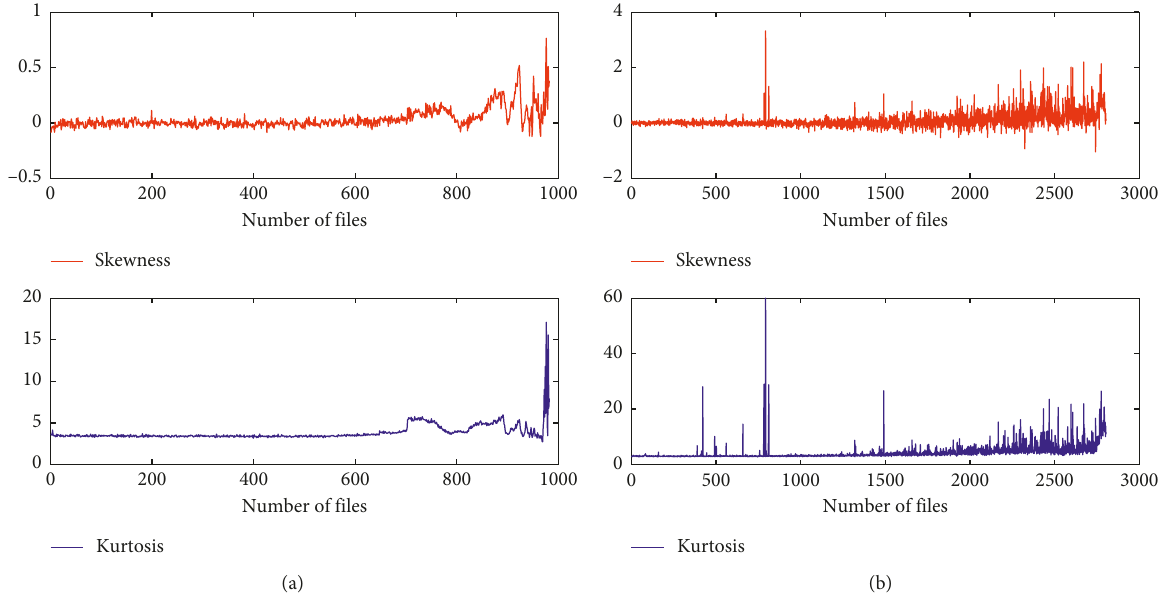
Figure 7: The skewness and kurtosis of the whole life of (a) Case I and (b) Case